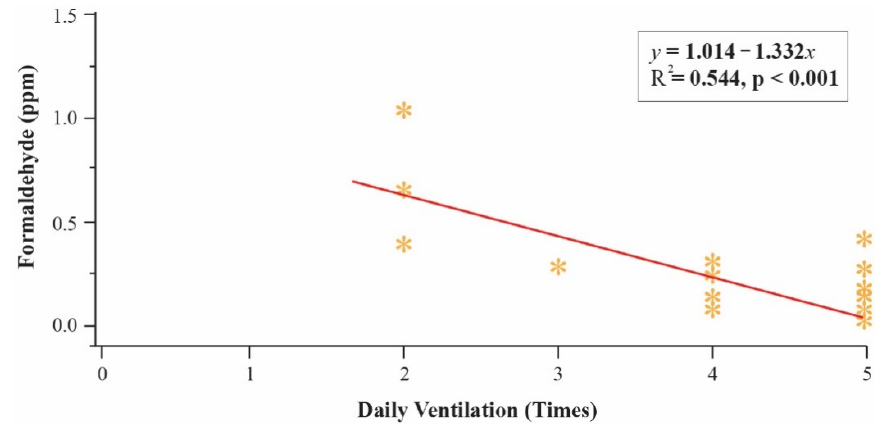
Figure 11. Formaldehyde (CH 2 O) concentration and daily ventilation.